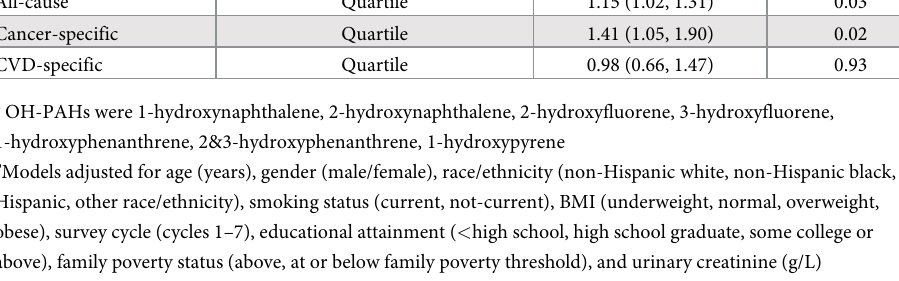
When including baseline cases, the adjusted risk estimates slightly increased for cancer-specific mortality, and decreased for CVD-specific mortality, but remained non-significant and ele- vated ( S5 Table ). In our quantile g-computation analysis ( Table 5 ), HR for the overall joint effect (simulta- adj neous quartile increase) of the eight OH-PAHs were 1.15 (95%CI: 1.02, 1.31), 1.41 (95%CI: